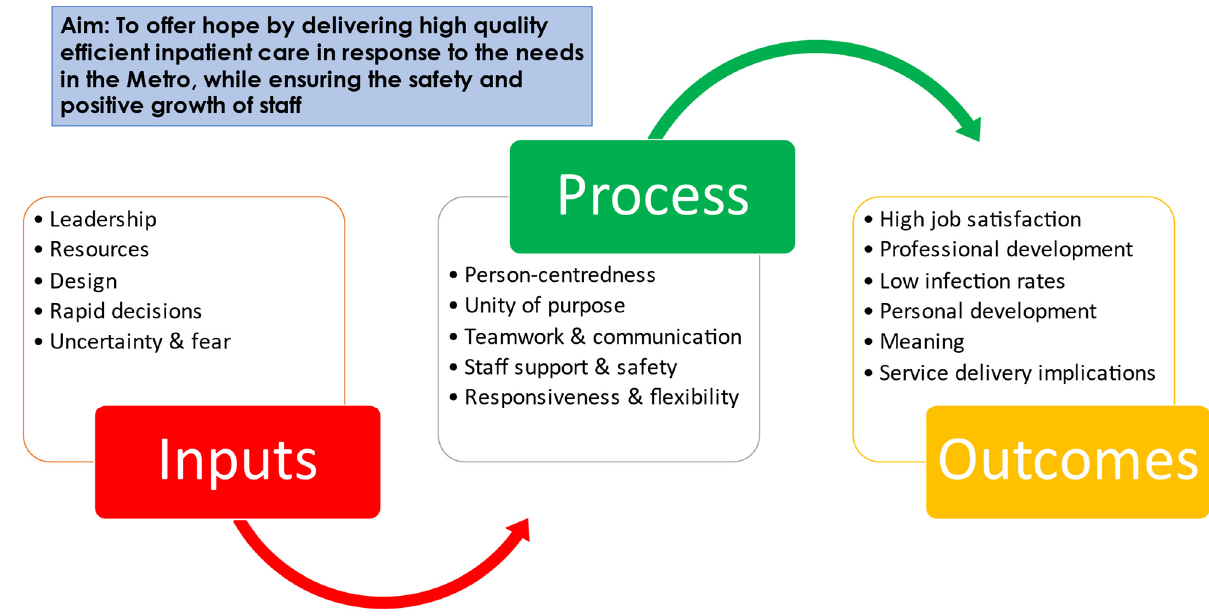
Figure 1. Overview of themes.